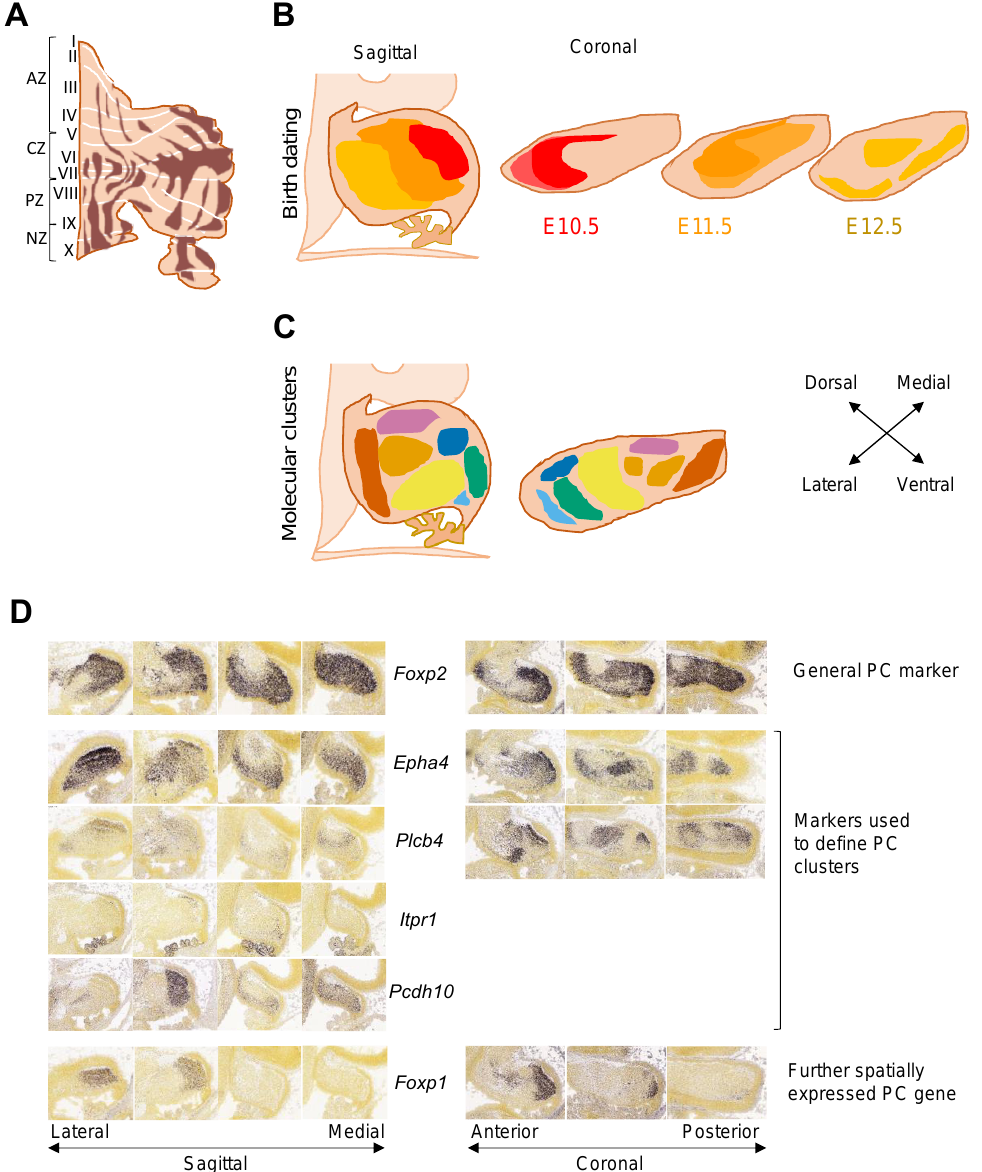
Figure 3. Purkinje cell embryonic clusters defined by imaging and birth dating studies in mice. ( A ) Zebrin stripes define Purkinje cell populations in the adult cerebellum. Stripes are parasagittal with most of the Z+ cells located in the posterior cerebellum. A complete description of the zebrin map is provided in [41] ( B ) E15.5 clusters can be defined by lineage tracing of different Purkinje cell birthdates E10.5 (red), E11.5 (orange), E12.5 (yellow) or ( C ) by expression of different combinations of molecular markers. Colors reflect different molecular clusters identified by [42]. Only one hemi- sphere of the cerebellum is shown in coronal diagrams. ( D ) Distribution of Purkinje cell markers at E15.5: Foxp2 is broadly expressed in most Purkinje cells. Epha4 , Plcb4 , Pcdh10, and Itpr1 are differen- tially expressed and often used as molecular markers to define distinct clusters. Foxp1 is included as an additional marker showing spatially specific expression in the anterior and lateral developing cerebellum. Images of sagittal and coronal sections from Allen Developing Mouse Brain Atlas (https://developingmouse.brain-map.org/ Accessed 7 th July 2022) are shown across lateral-medial and anterior-posterior axis. Coronal sections were not available for Pcdh10 and Itpr1 . A, anterior;